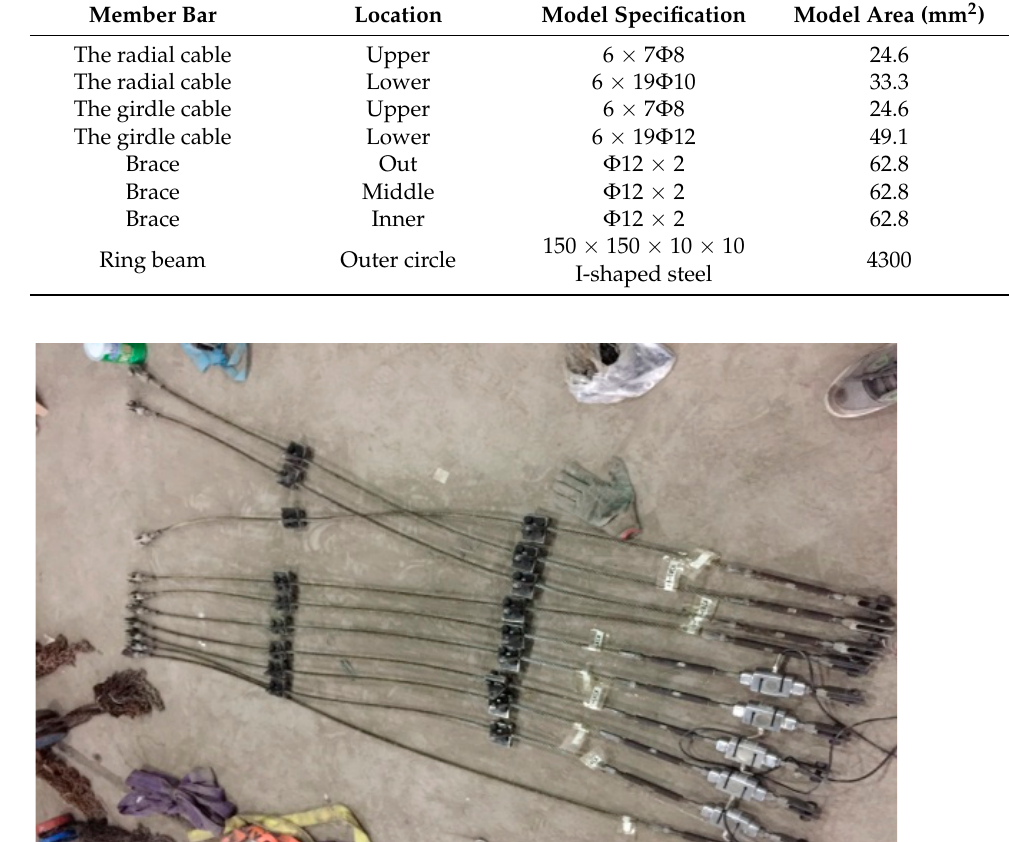
Table 1. Model material selection specifications.